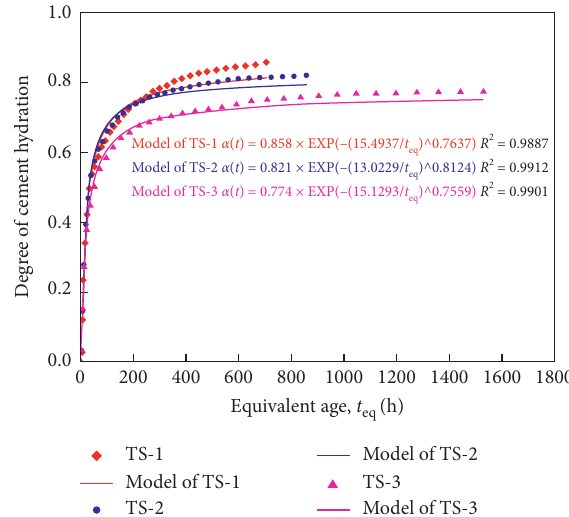
Figure 3: Test value and fitting value of cement hydration degree and equivalent age in the concrete of TS-1 concrete, TS-2 concrete, and TS-3